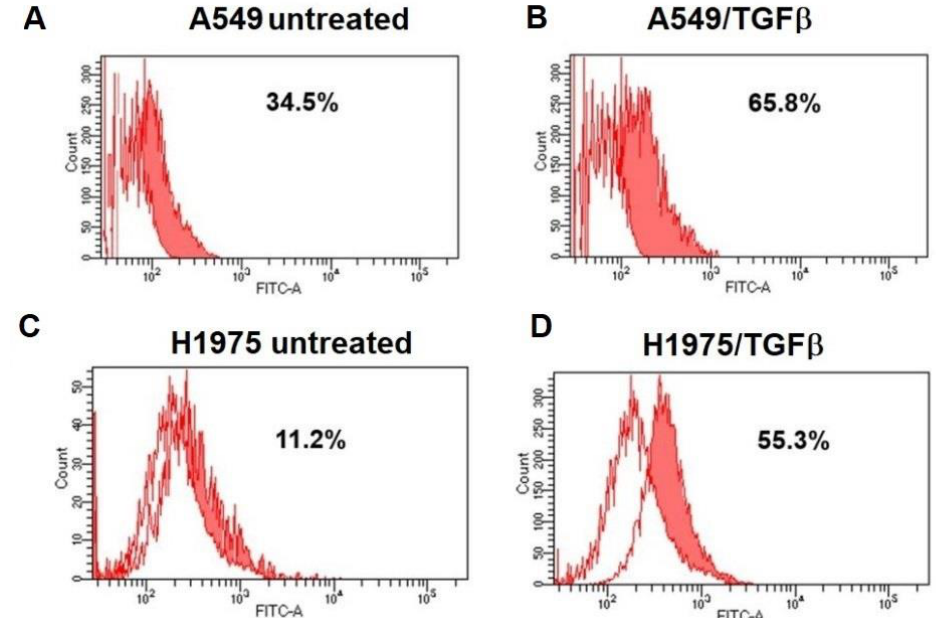
Figure 2. Expression of α v β 6 integrin receptor in A549 ( A , B ) and H1975 ( C , D ) NSCLC cells. Cells were grown for 48 h in the absence (left panels, A , C ) or in the presence (right panels, B , D ) of TGF β (10 ng/mL). Cells were stained with mouse anti-human α v β 6 antibody followed by FITC-conjugated anti-mouse immunoglobulin (full histograms). As a negative control (open histogram), cells were stained with FITC-conjugated anti-mouse immunoglobulin.